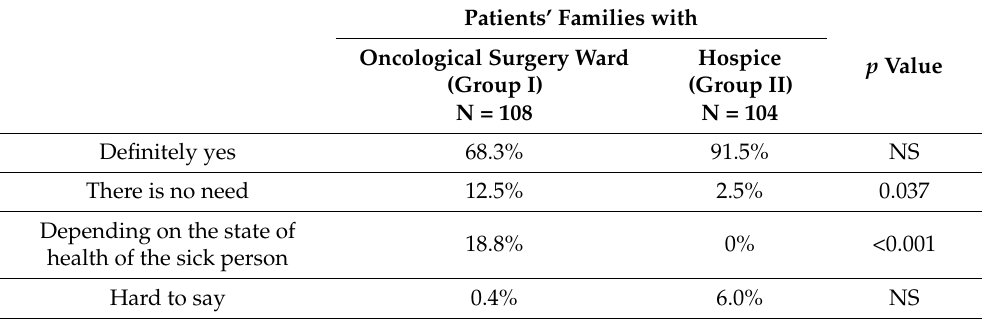
Table 9. Opinion on the participation of the family in the care/treatment of a sick